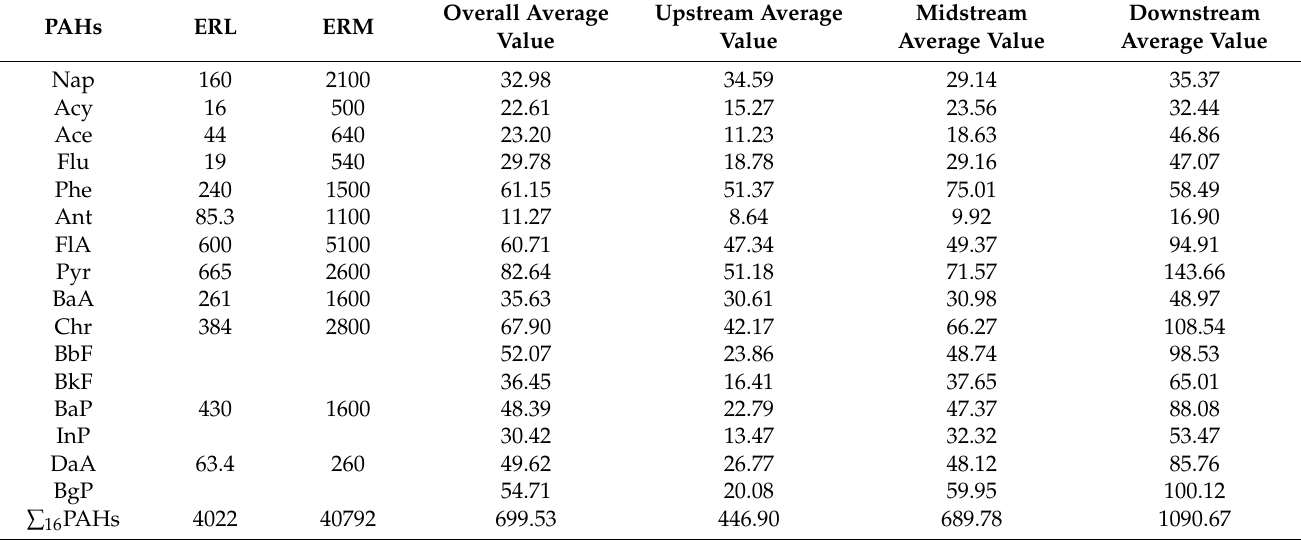
Table 6. Comparison of concentrations of PAHs in sediments in different areas with ERL and ERM (Unit: ng/g). ERL ERM